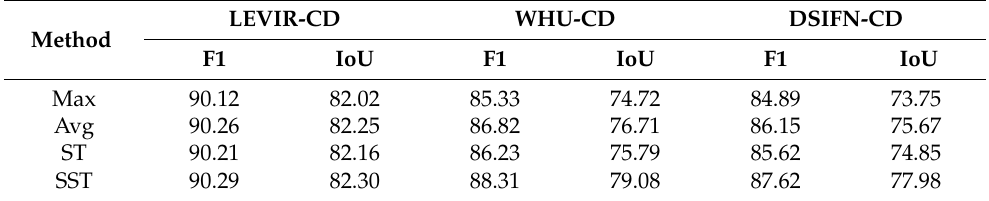
Table 4. Ablation studies of SST on three test sets.